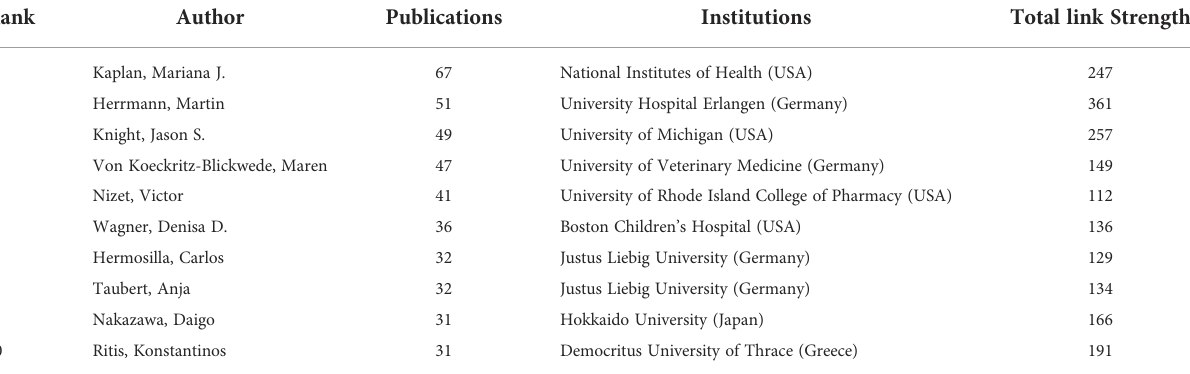
TABLE 3 Top 10 authors in terms of number of publications, the corresponding institutions and total link